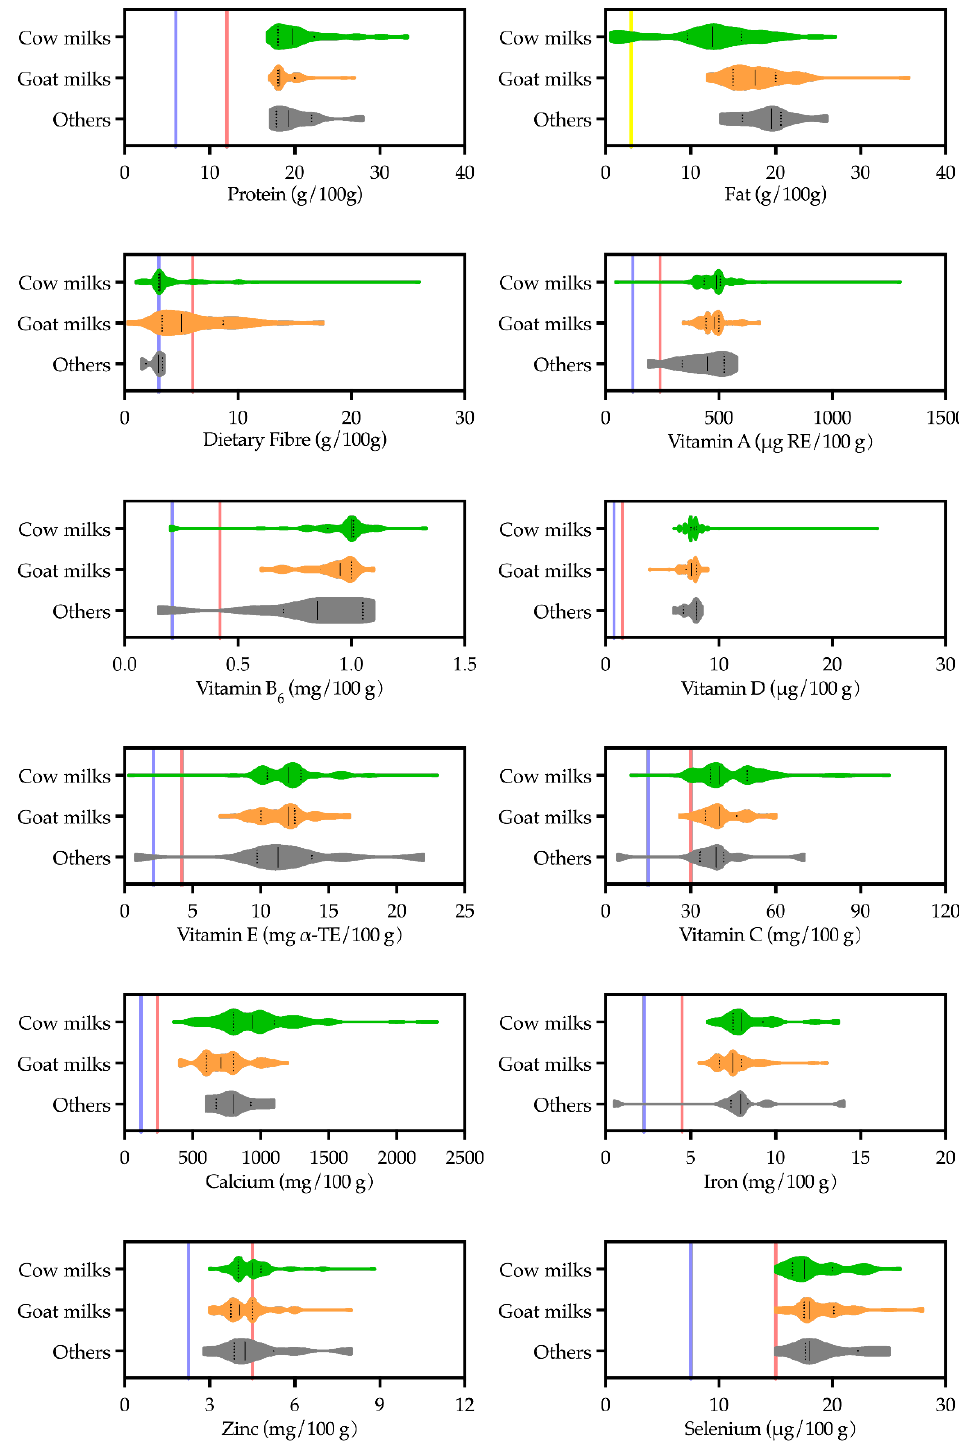
Figure 7. Nutrient concentrations for cow, goat and other milk powders targeting Chinese older adults. The solid line and dash line in the violin bars represent the median and quartiles, respec- tively. The colour lines are the minimum requirements to make nutrition content claims as high ( ), ), low ( ), low ( ), and contains ( ), respectively, according to Food Safety National Standards for nutrition labelling of pre-packed foods (GB 28050- 2011). ‘Others’ includes yak , camel and sheep milks.